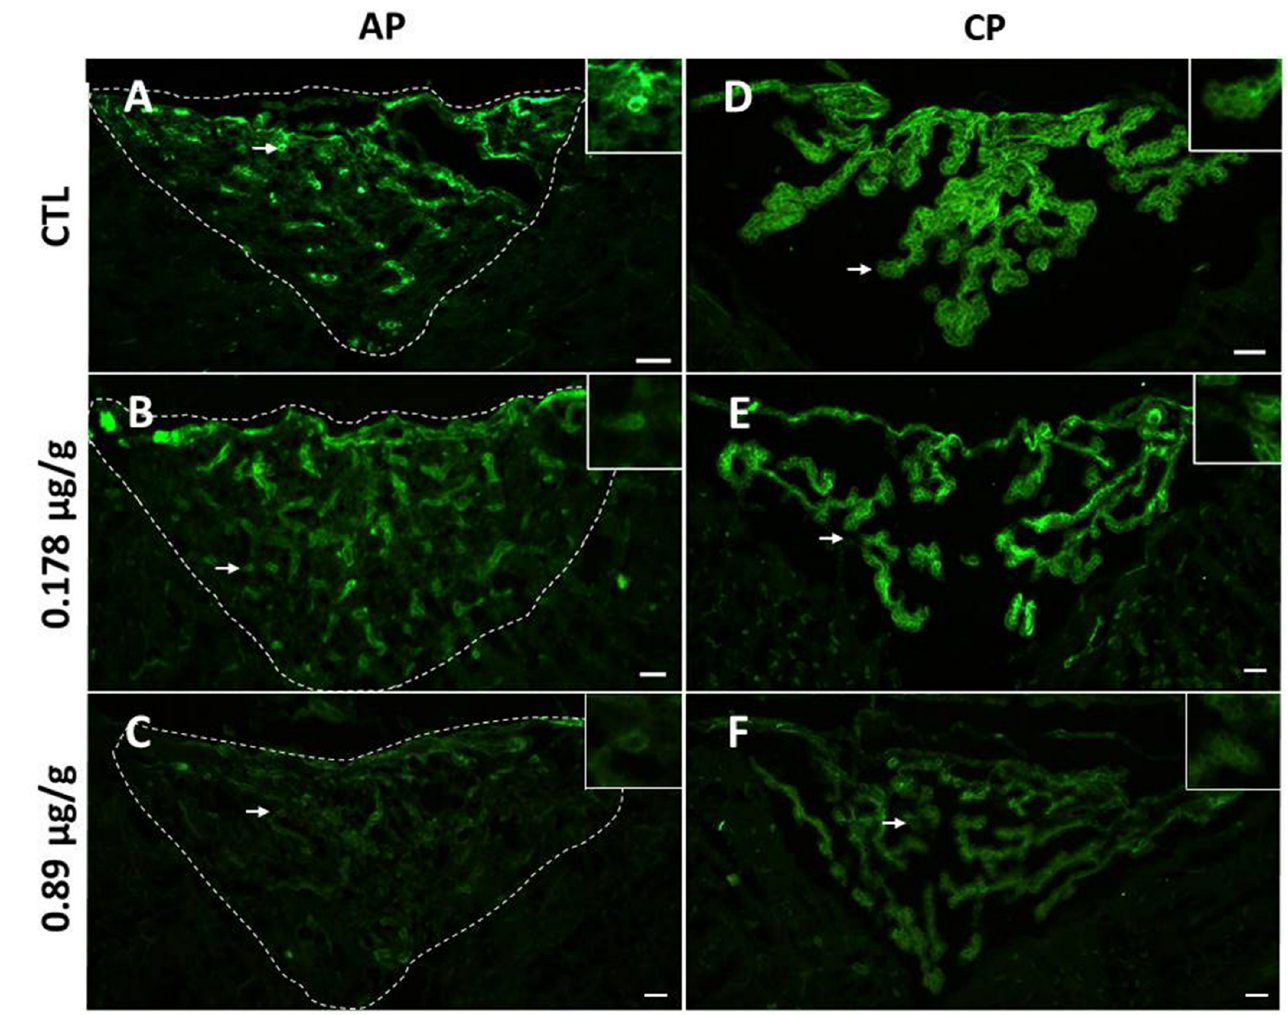
Fig 6. Effect of LAv on laminin γ from AP and CP. (A) Control treatment AP section, showing normal distribution of laminin γ surrounding uniformly AP capillaries; (B) AP section treated with 0.178 μ g/g LAv; (C) AP section treated with 0.89 μ g/g LAv; (D) Control treatment CP section, showing normal distribution of laminin γ surrounding ependymal cells from CP; (E) CP section treated with 0.178 μ g/g LAv; (F) CP section treated with 0.89 μ g/g LAv. Magnification on each panel corresponds to areas indicated with white arrows. Scale bars = 50 μ